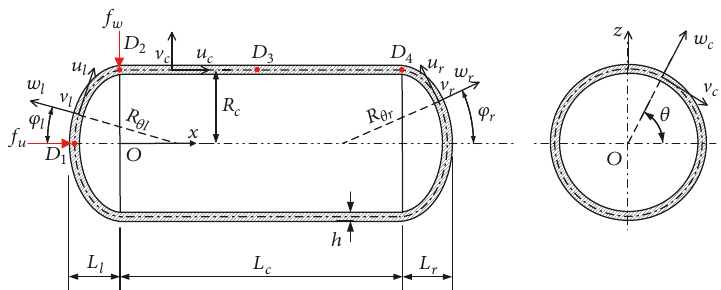
Figure 1: Cross section and coordinate systems of an airtight cylindrical